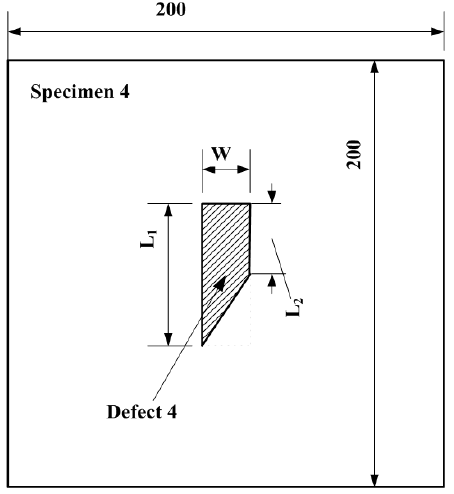
Figure 2. The planform of specimen 4 with irregular defect 4.